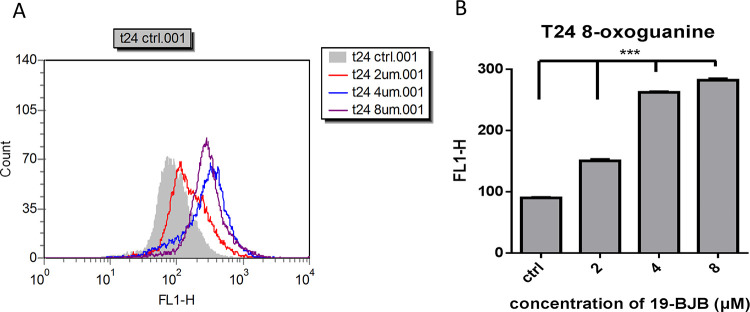
Fluorescence response of 8-oxoguanine in T24 cells after treated with 19-BJB for 24 h.(A) The FL1-H average values of deferent groups detected by flow cytometry. (B) The results were performed in column bar graphs. Error bars represent standard error of the mean, *** p < 0.001.